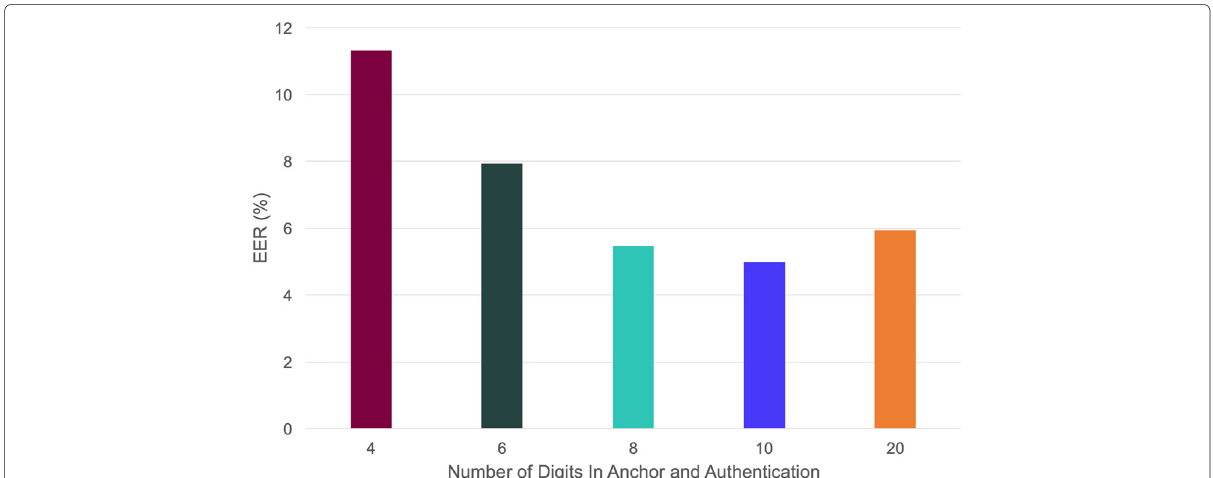
Fig. 8 Figure shows the performance using LipAuth trained on XM2VTS data tested on the qFace dataset for varied length sequences. Results reported on authentication sequences of matched number of digits to the Anchor video